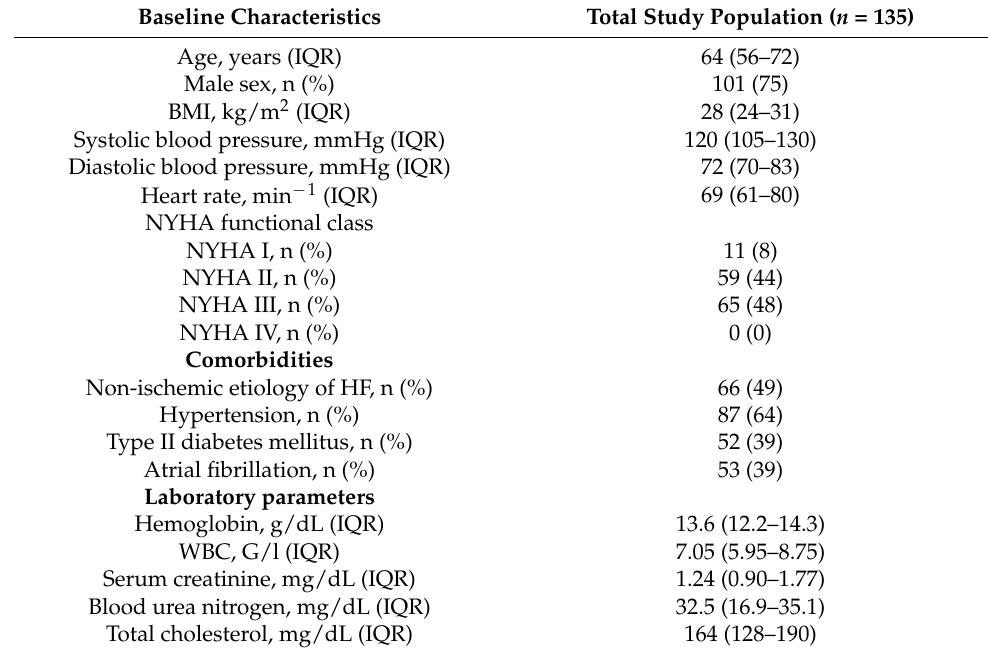
Table 1. Baseline characteristics of the total study population ( n = 135). Continuous variables are given as median and interquartile range, counts are given as numbers and